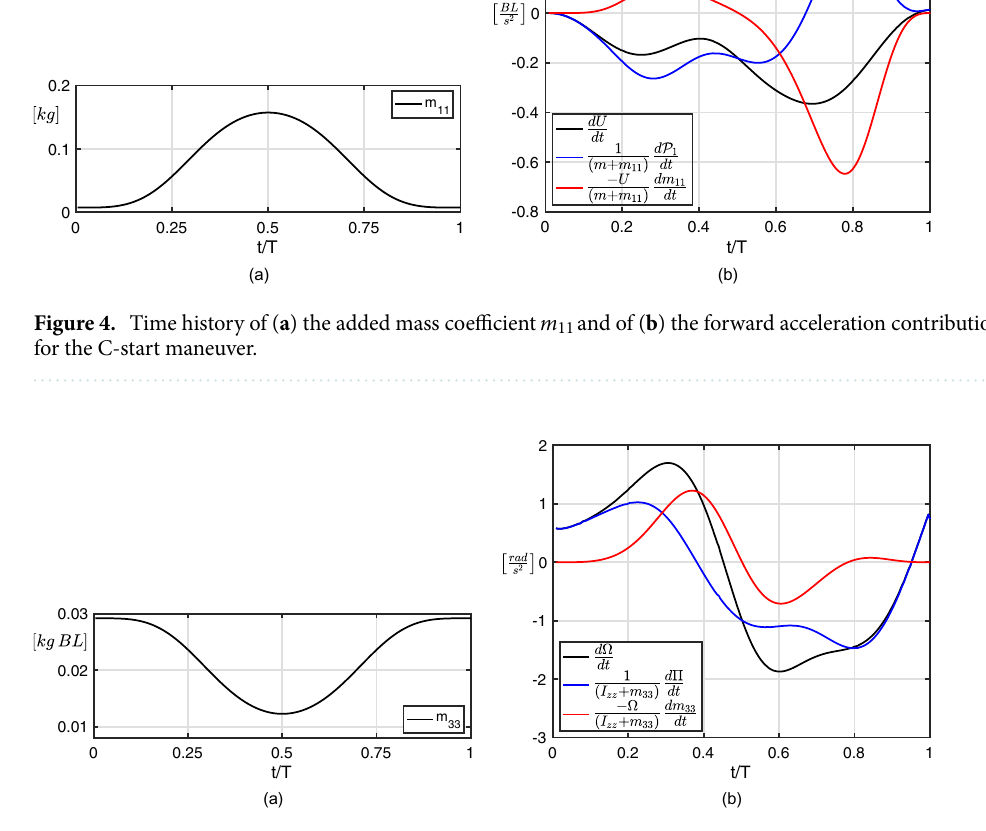
Figure 5. Time history of ( a ) the added mass coefficient m 33 and of ( b ) the angular acceleration contributions for the C-start